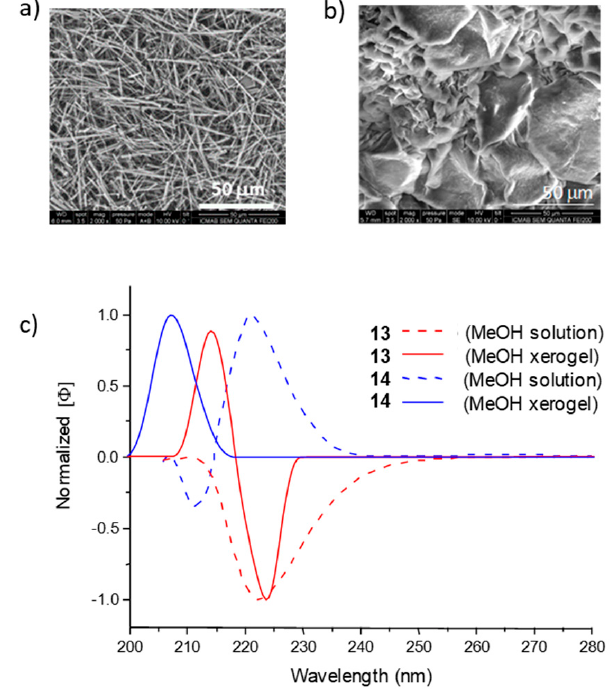
Figure 10. Top: SEM images of xerogels from methanol at the cgc of: ( a ) 13 , ( b ) 14 . Magnification 50 µm. ( c ) Normalized CD spectra of 13 and 14 , respectively, in methanol solution (2.4 mM for 13 and 2.7 mM for 14) and as xerogel from methanol in KBr (20 mM) at 25 °C [38].